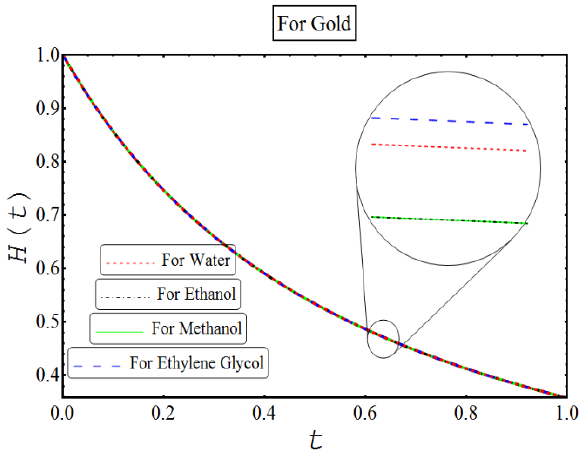
Figure 2. Behaviour of film thickness for different base fluids containing gold nanoparticles. Coatings 2018 , 8 , x FOR PEER REVIEW